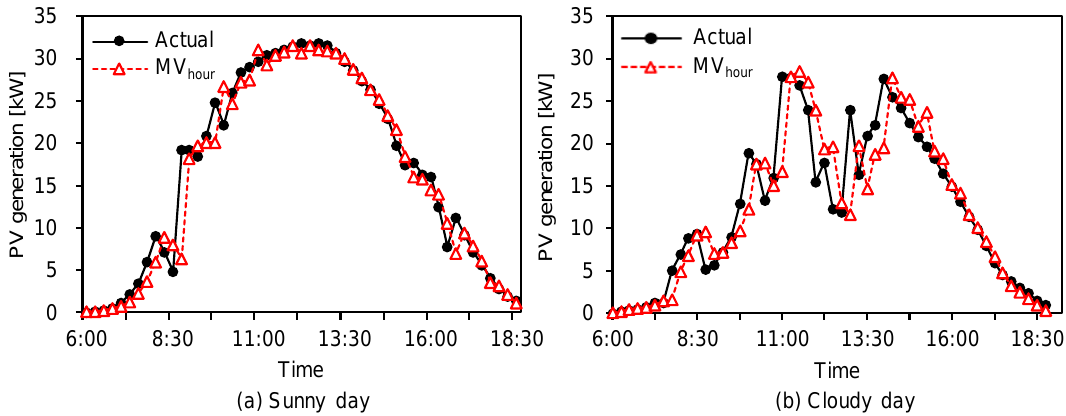
Figure 1. MV hour model forecast; ( a ) PV forecasting on a sunny day; ( b ) PV forecasting on a cloudy day.